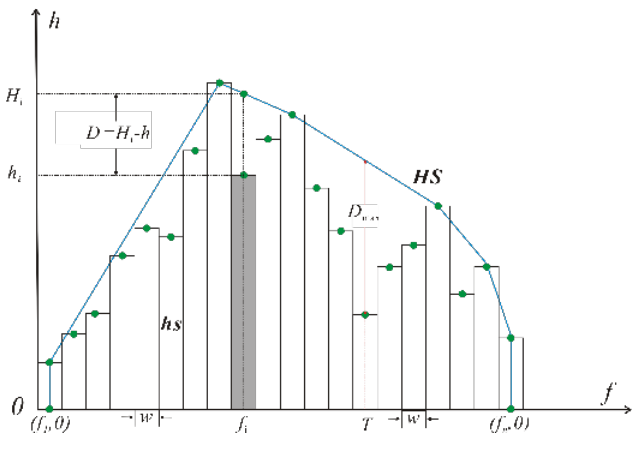
Figure 4. Histogram concavity analysis.